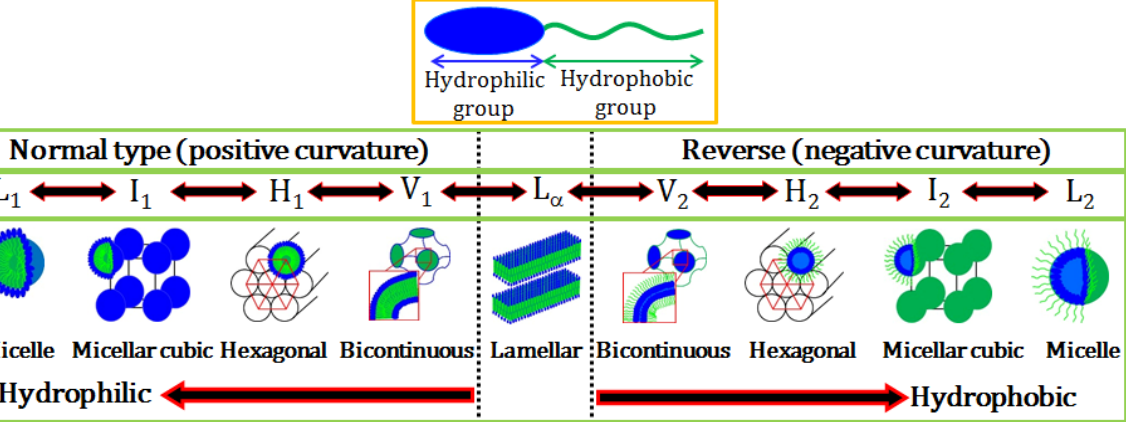
, I , H , V , and L represents normal 1 1 1 1 α , I , H , and L respectively represent reverse (inverted) 2 2 2 2